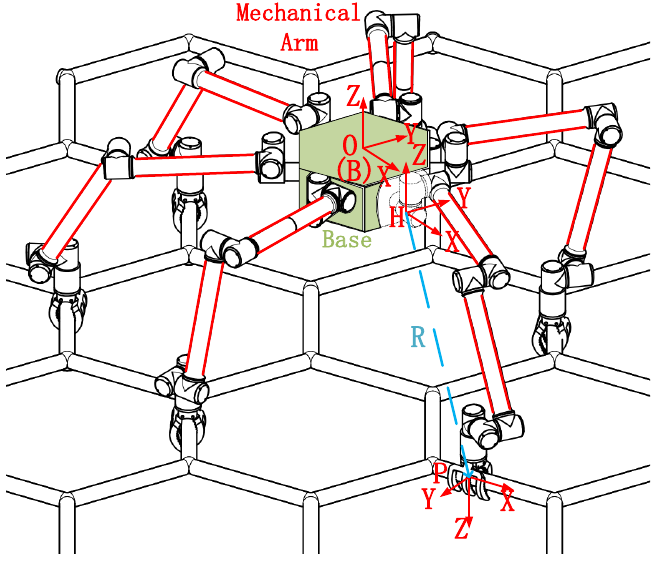
Figure 1. Mechanism diagram of a space dobby robot.